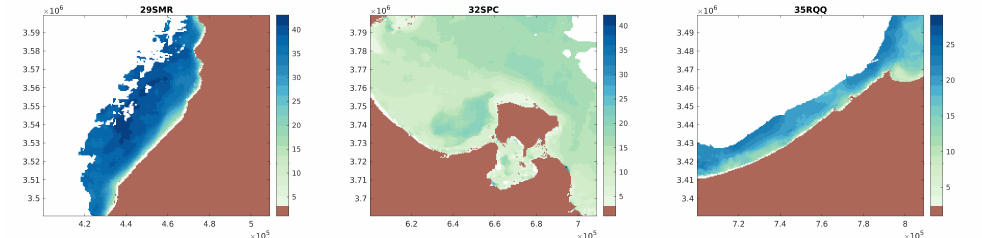
Figure 6. Illustration of S2Shores satellite-derived coastal bathymetry at showcases zones. The the tiling grid IDs for Sentinel 2 are given at the top of each